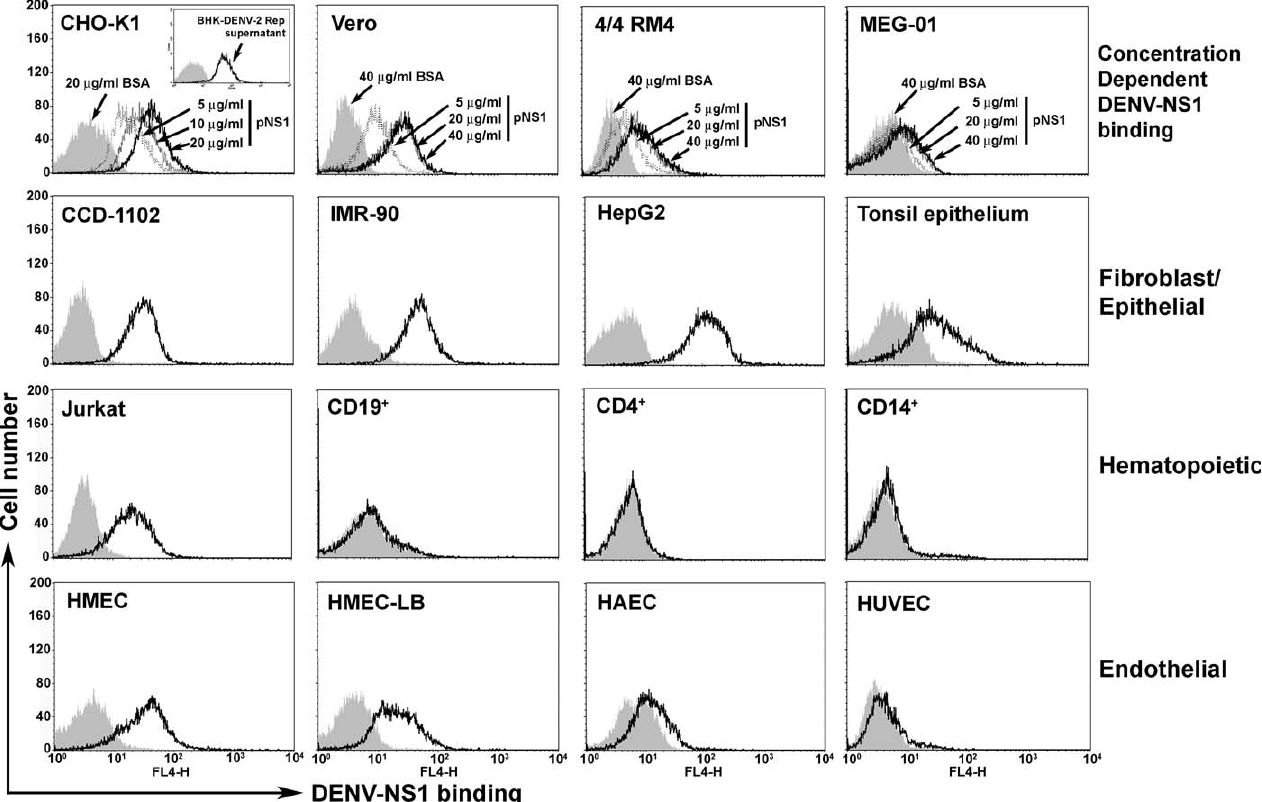
Figure 2. DENV NS1 Binds to Cells of Specific Lineages Dose-dependent binding of DENV NS1 to cell surfaces. Purified DENV NS1 (5, 10, 20, and 40 l g/ml) was added to different cell types at 4 8 C for 1 h. After washing, bound NS1 was detected by anti-NS1 antibody staining and flow cytometry. An example of DENV NS1 binding to CHO-K1 cells using supernatant from BHK-DENV-2 Rep cells is depicted in the inset at the upper right corner of the top left histogram. Examples of histogram profiles of DENV NS1 binding to epithelial, fibroblast, hematopoietic, and endothelial cells are depicted. One representative of three experiments is shown. No specific staining was observed after BSA binding and incubation with an NS1 antibody or NS1 binding and incubation with an isotype-matched control antibody (unpublished